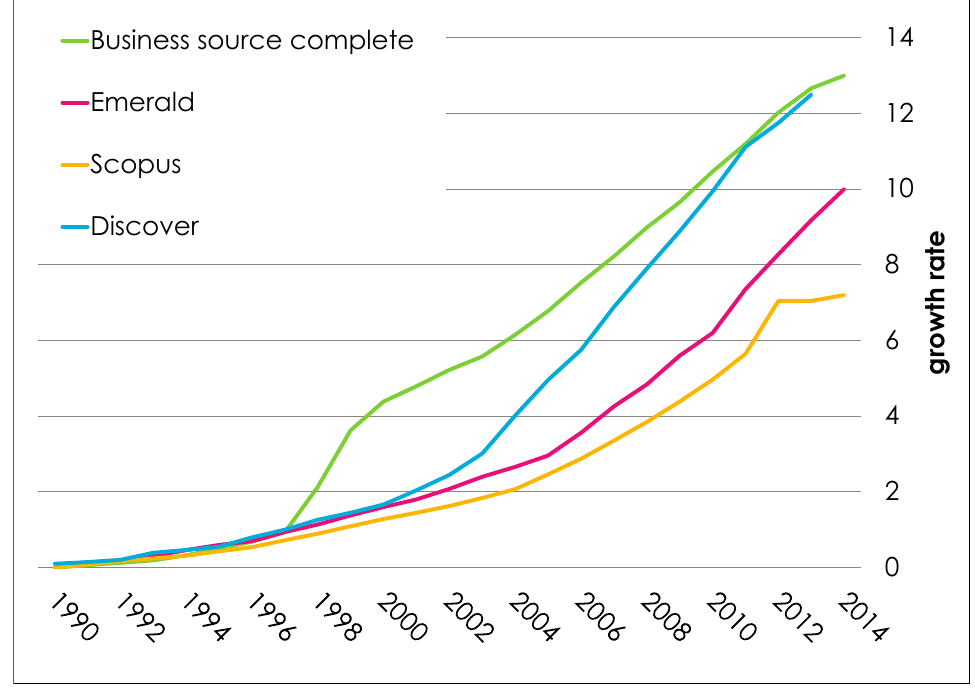
Figure1 Growth rate of maturity-related publications in a management